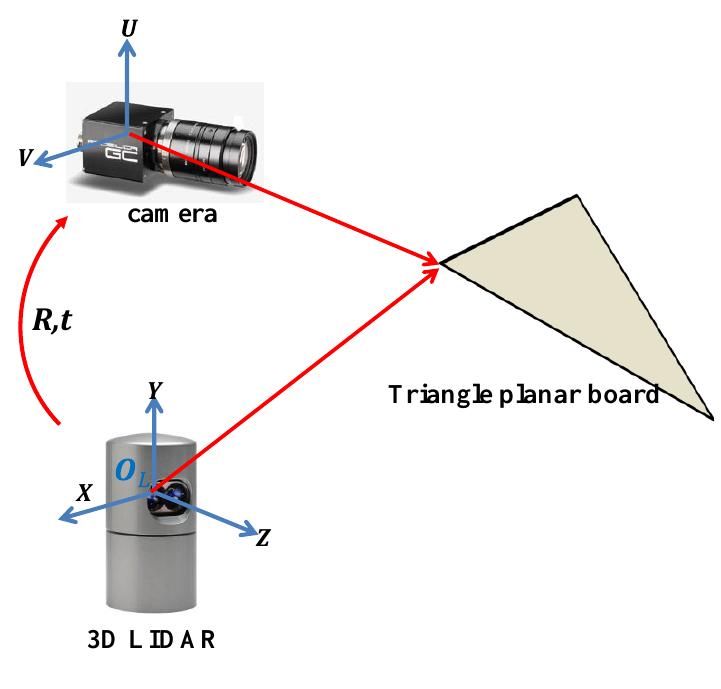
Figure 3. Calibration configuration of a camera and 3D LIDAR with a triangle